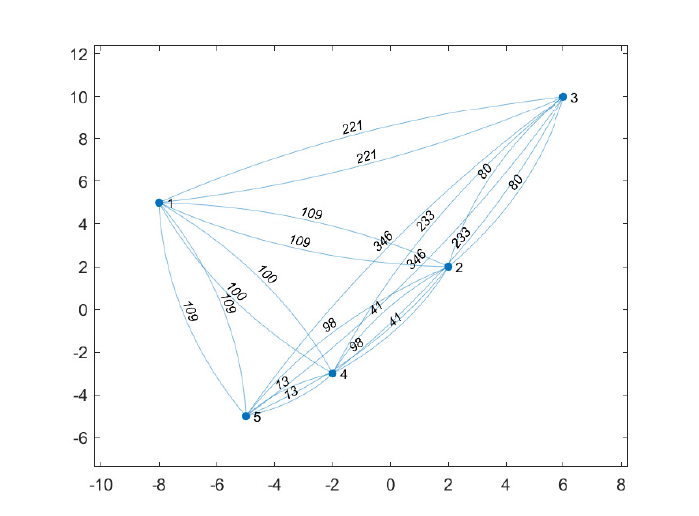
Figure 3. Nodes show that the locations (positions) of the five CH robots. The weight of a link shows the square of distance between the two nodes connected via that